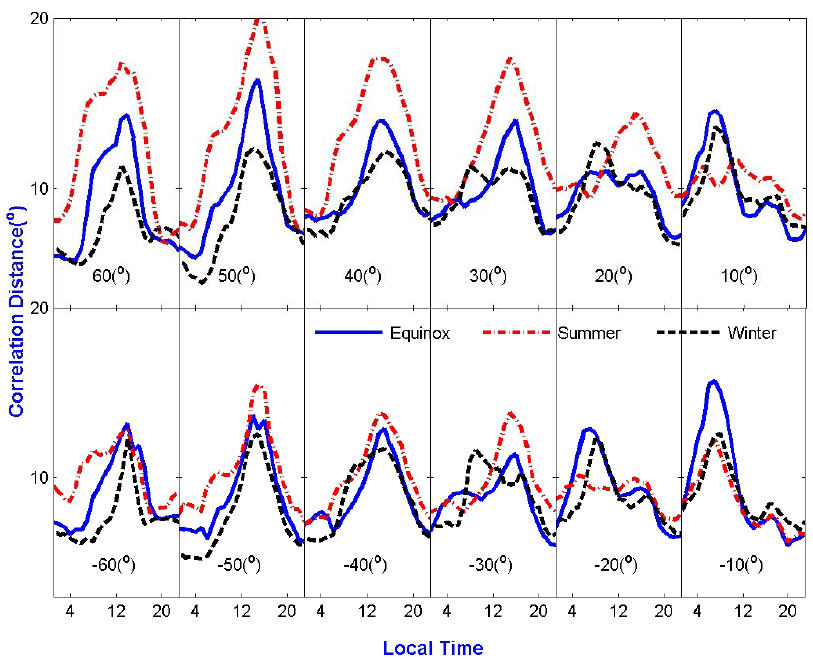
Figure 3b. Local time variations of meridional correlation distance in 12 selected latitudes for equinox (solid lines), summer (dash-dot lines), and winter (dashed lines), respectively.